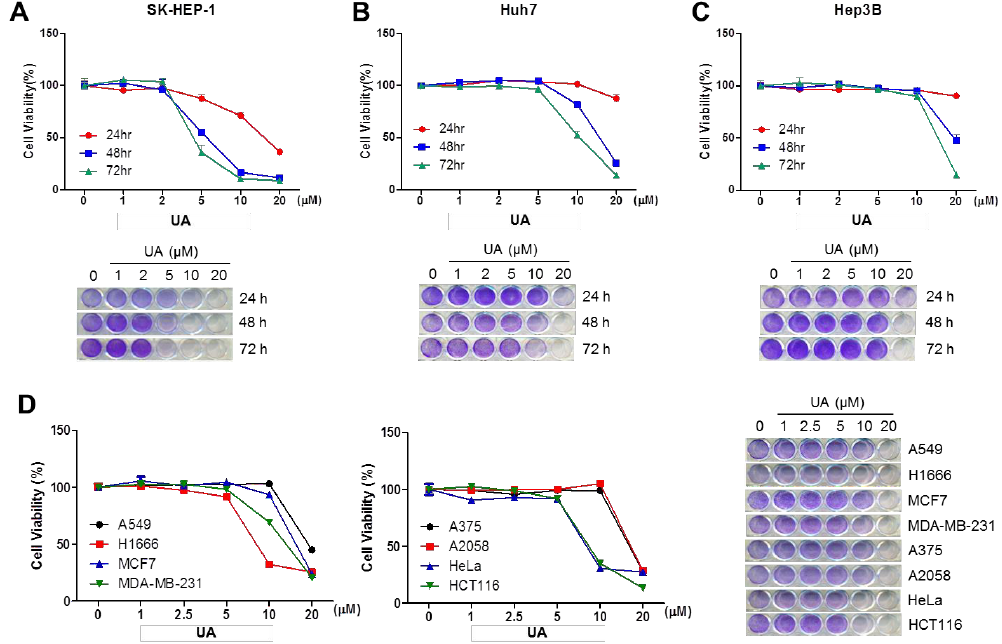
Figure 4. UA attenuates cell viability in HCC cells. ( A ) SK-HEP-1 cells were incubated with UA at different concentrations for 24, 48, and 73 h, as indicated. ( B ) Attenuation of cell viability by UA treatment was measured in Huh7 cells. ( C ) Attenuation of cell viability by UA treatment was measured in Hep3B cells. ( D ) Attenuation of cell viability by UA treatment was measured in lung (A549 and H1666), breast (MCF7 and MDA-MB-231), melanoma (A375 and A2058), cervical (HeLa) and colon (HCT116) cancer cells. Cell viability was measured by crystal violet staining, and the values represent the mean from three independent experiments performed in duplicate.